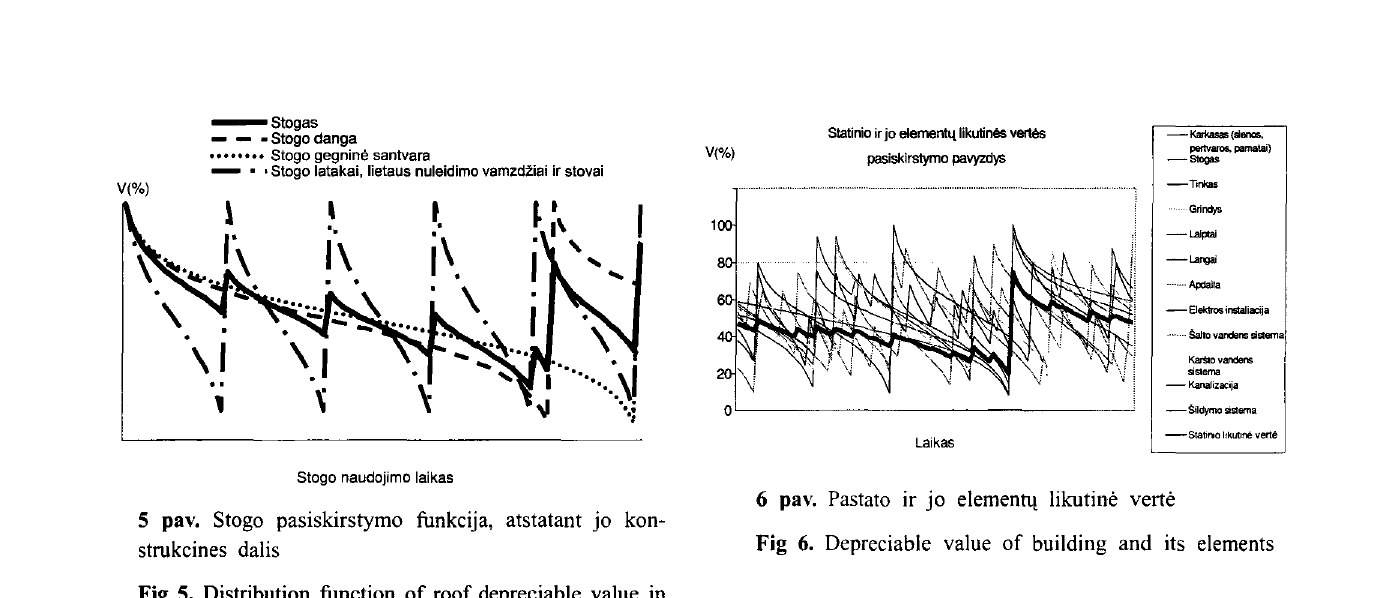
Fig 5. Distribution function of roof depreciable value in case, when components are reconditioned